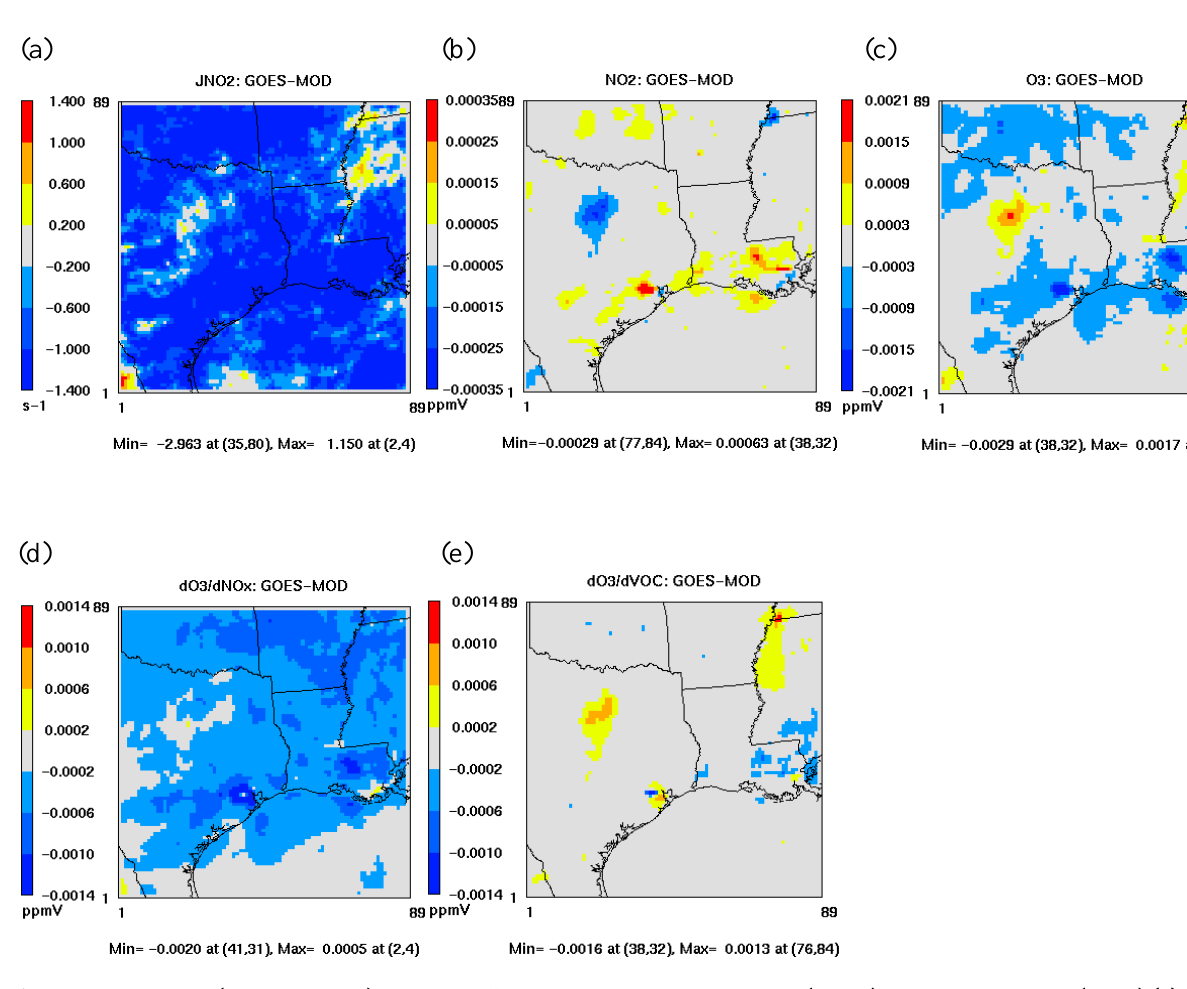
Figure 3. Monthly 8h (10:00–18:00LT) averaged differences between satellite-derived (GOES) and model-predicted (MOD) (a) JNO 2 in simulating (b) NO 2 , (c) O 3 , and O 3 sensitivities to (d) NO x and (e)